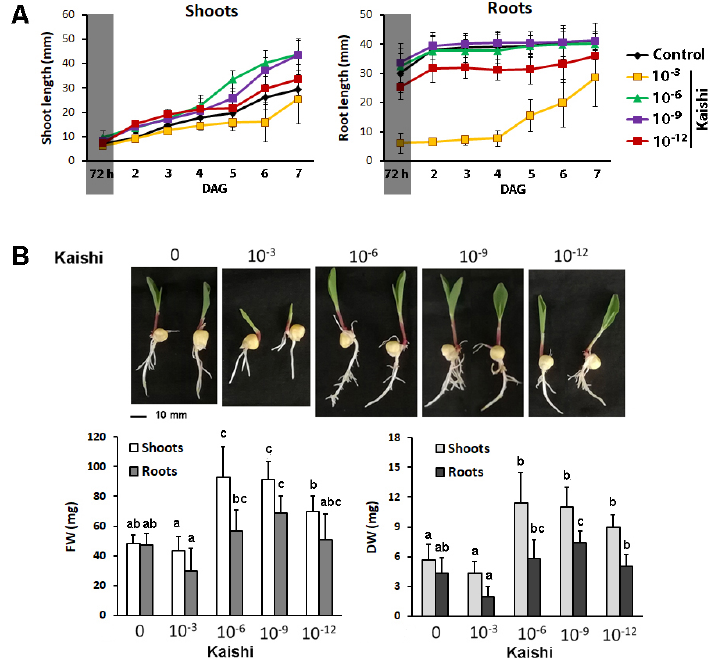
Figure 4. Effects of different amounts of the biostimulant on plant germination and growth in hydroponic cultures. ( A ) Germination for 72 h in darkness (reflected by a shaded sector on the graph) and organ growth on Kaishi containing media; ( B ) phenotype , fresh weight (FW), and dry weight (DW) of shoots and roots of 7-day-old plants on Kaishi containing media. The different lowercase letters designate statistically significant differences at p ˂ 0.05, and the error bars represent SD ( n ≥ 20, multifactor ANOVA).